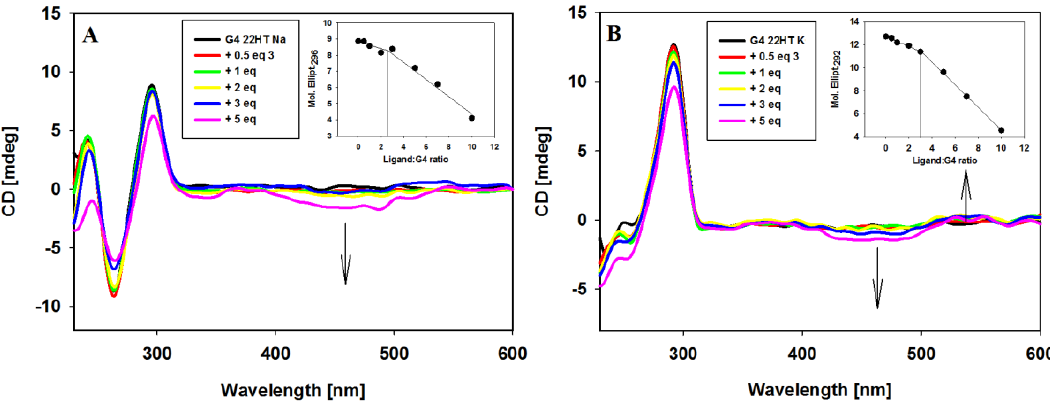
Figure 7. Circular dichroism (CD) spectra of G-quadruplex 22HT (5 µ M) with increasing amounts of ligand 3 in Tris-HCl buffer (10 mM, pH 7.2) containing 100 mM NaCl ( A ) and 100 mM KCl ( B ).